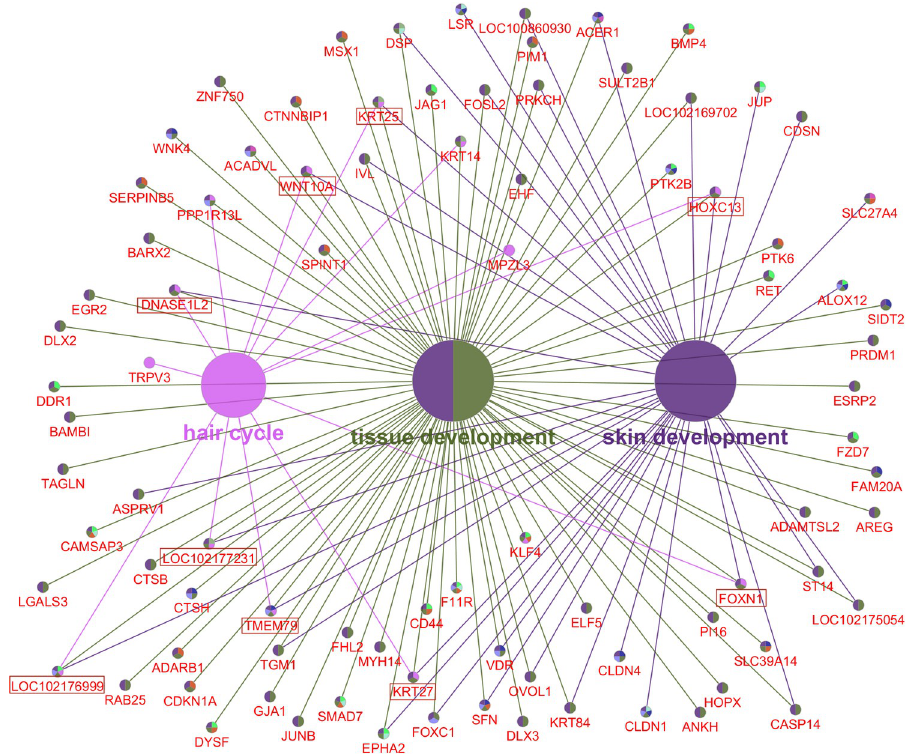
Fig 10. Gene enrichment map of skin follicle development and GO-biological process. Large nodes: GO terms directly involved in the biological process of skin hair follicle development; small nodes: Enriched genes; red boxes: Enriched to three GO